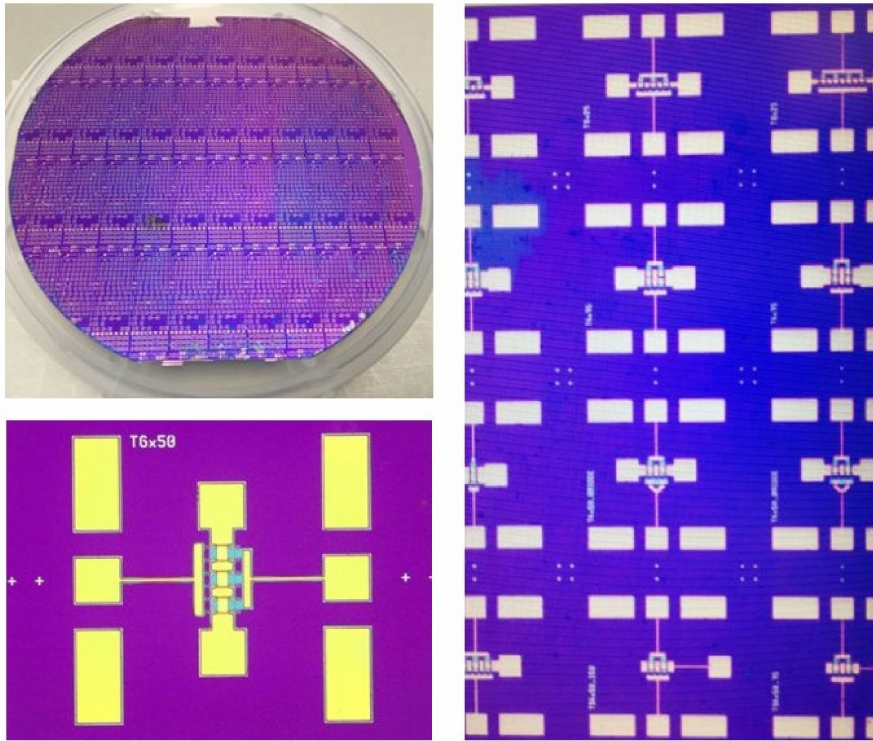
Figure 3. One of the 3-inch wafers (left-upper corner), wafer fragment (right side), transistor topology on the wafer (left-down corner).